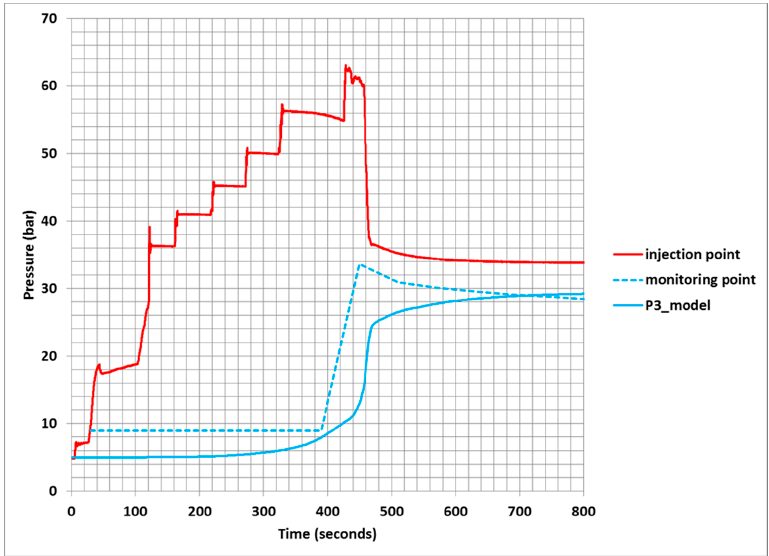
Figure 7. Comparison of simulated at measured pressure response at monitoring point.